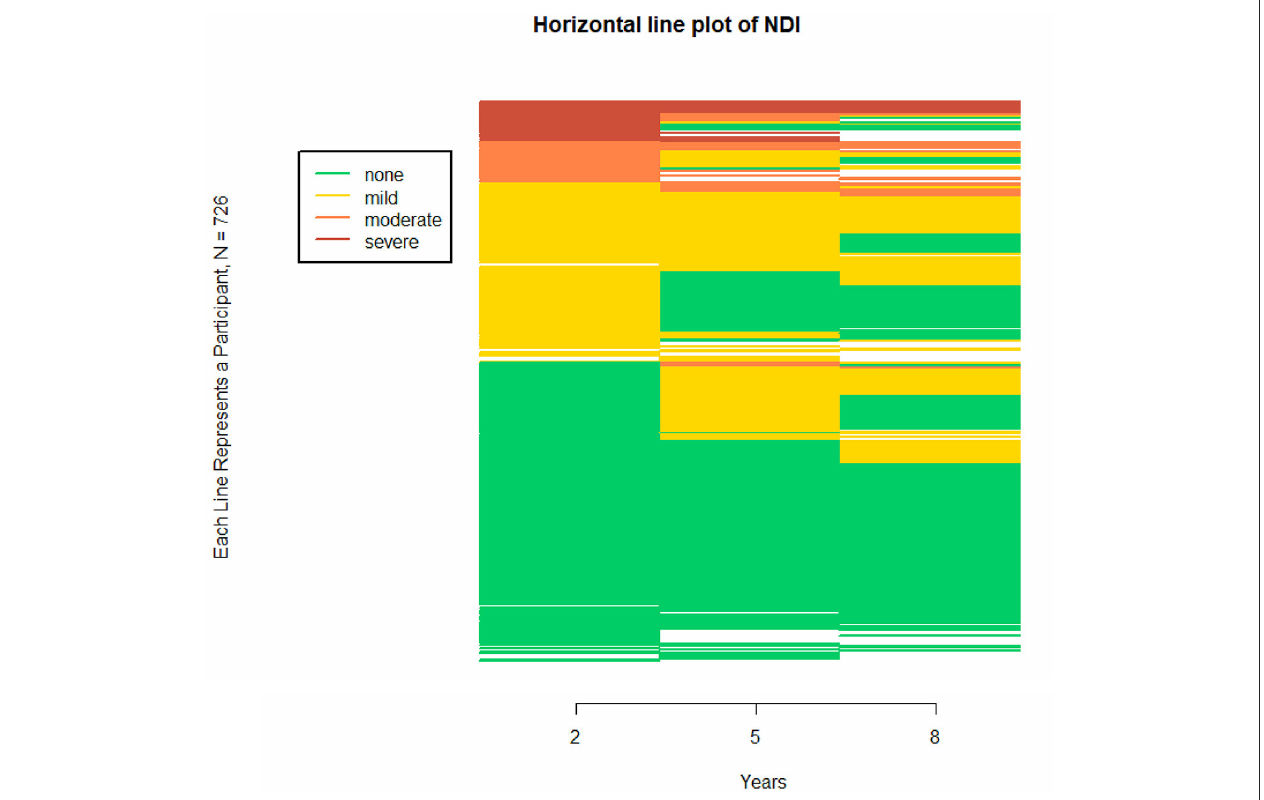
FIGURE 3 | Individual trajectories of neurodevelopmental impairment (NDI) at different ages, presented in a horizontal line plot for all children with follow-up. The horizontal line plot uses colors to differentiate between states on a categorical longitudinal variable for multiple participants. Because categorical data defines a specific state, a trajectory for a categorical variable becomes a sequence of states rather than a continuum. The figure consists of 726 stacked horizontal line, with each horizontal line representing a participant. In this figure, NDI category is presented at 2, 5, and 8 years of age. This figure shows overall patterns of increasing and decreasing trajectories, including patterns in missing data. The blank spaces indicate missing data for that follow-up age.